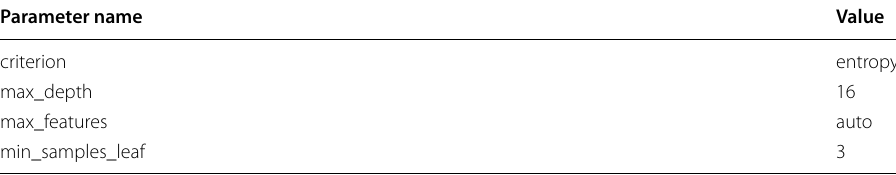
Parameter values for classifier yielding best results in terms of AUC